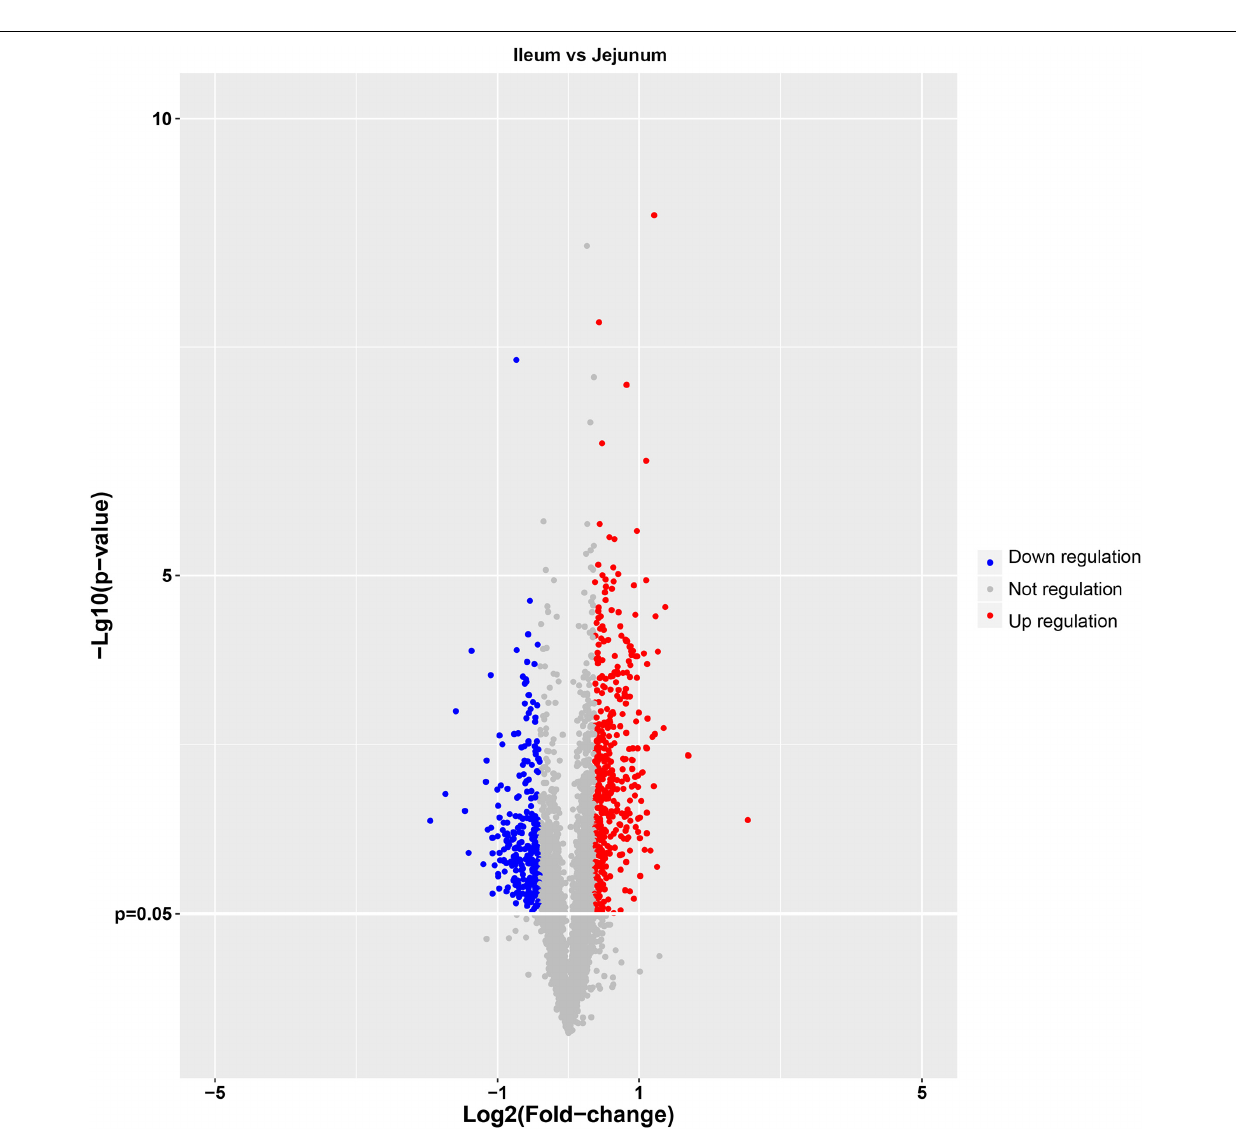
FIGURE 2 | Volcano map of differentially expressed proteins. The abscissa represents the fold change (log2 value) of differentially expressed proteins, and the ordinate represents the P -value (–log10). Gray points represent proteins with insignificant differences, red points represent up-regulated proteins, and the blue points represent down-regulated